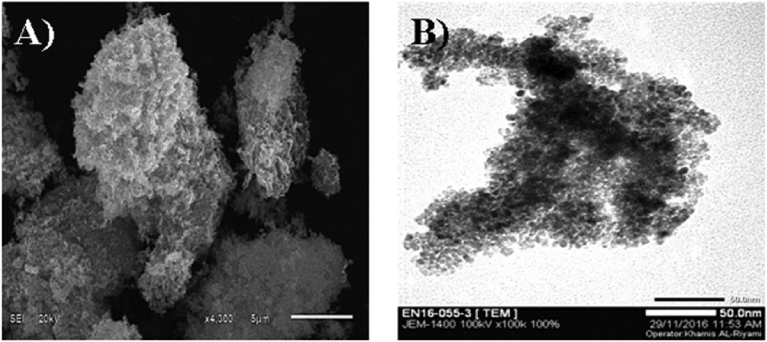
A, and B SEM and TEM images for NiO:V2O5 composite respectively, 500 °C and pH 1.8.